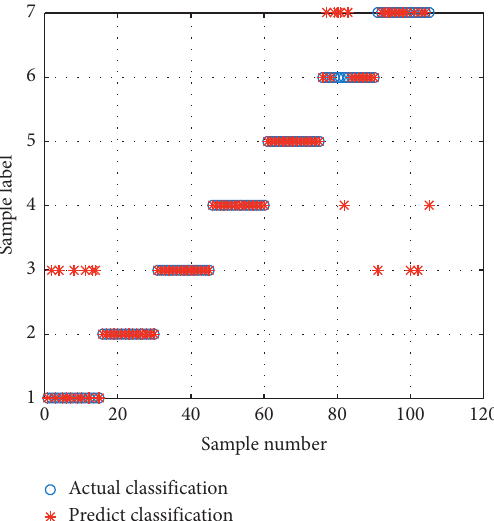
Figure 12: Classification results of VMD-SVM.